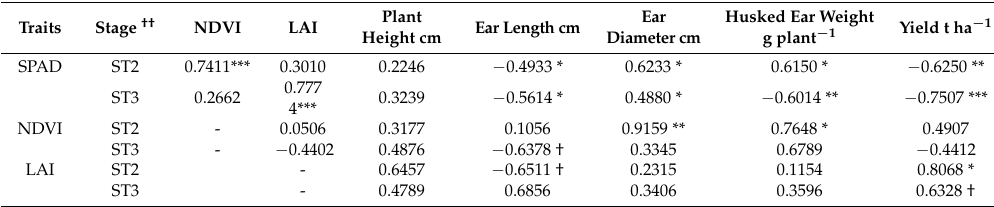
Table 4. Correlation coefficients ( r ) between the spectral traits, LAI and yield of sweet corn under deficit irrigation (I 0.5